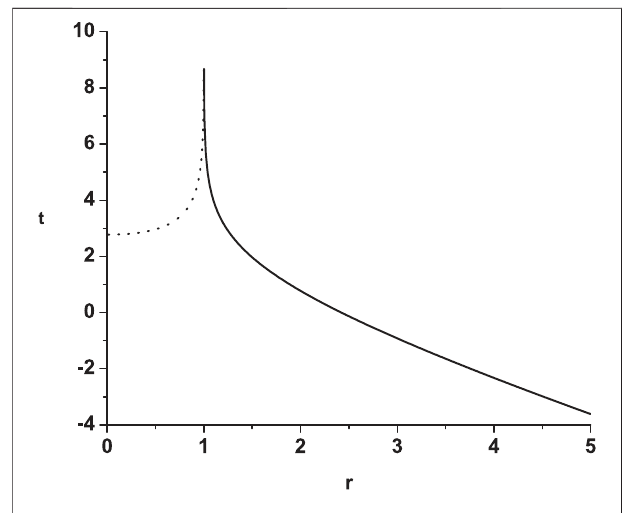
FIGURE 4 | An ingoing wave toward the black hole. The curve represents V = C =const trajectory expressed in the Schwarzschild coordinates. Here we set C = 4. In the beginning, there is only one solid line that goes from r = ∞ inward to the horizon, r = 1. Then at t = 2ln C a dotted line appears propagating from r = 0 to the horizon r = 1. The solid and dotted lines represent the positive and negative energy components